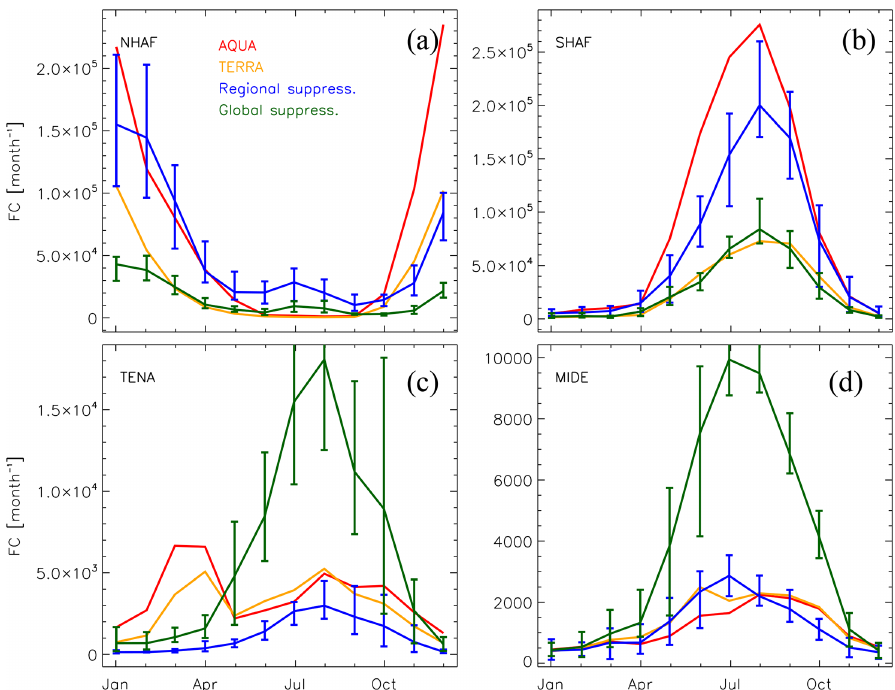
Figure 4. Seasonality of total active fires for NHAF (a) , SHAF (b) , TENA (c) , and MIDE (d) observed by MODIS Aqua (red) and Terra (orange) and simulated with explicit regional suppression (blue) and generic global suppression parameterization (green) (Eq. 6). Error bars represent the range over 10-year climatological simulations. Note that TERRA and AQUA have different overpass times, and the model data presented here are monthly means. Also note the different scales in each